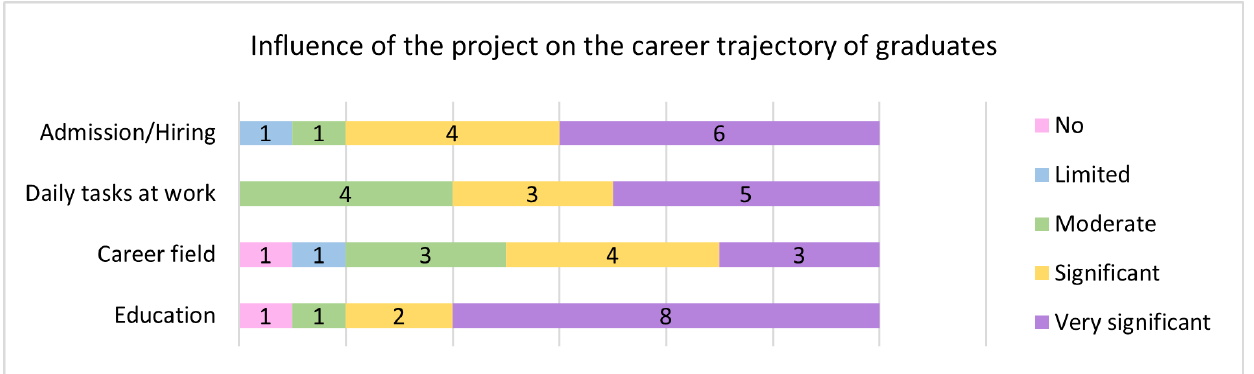
Figure 4. Influence of the project on the professional trajectory of graduates (questionnaire